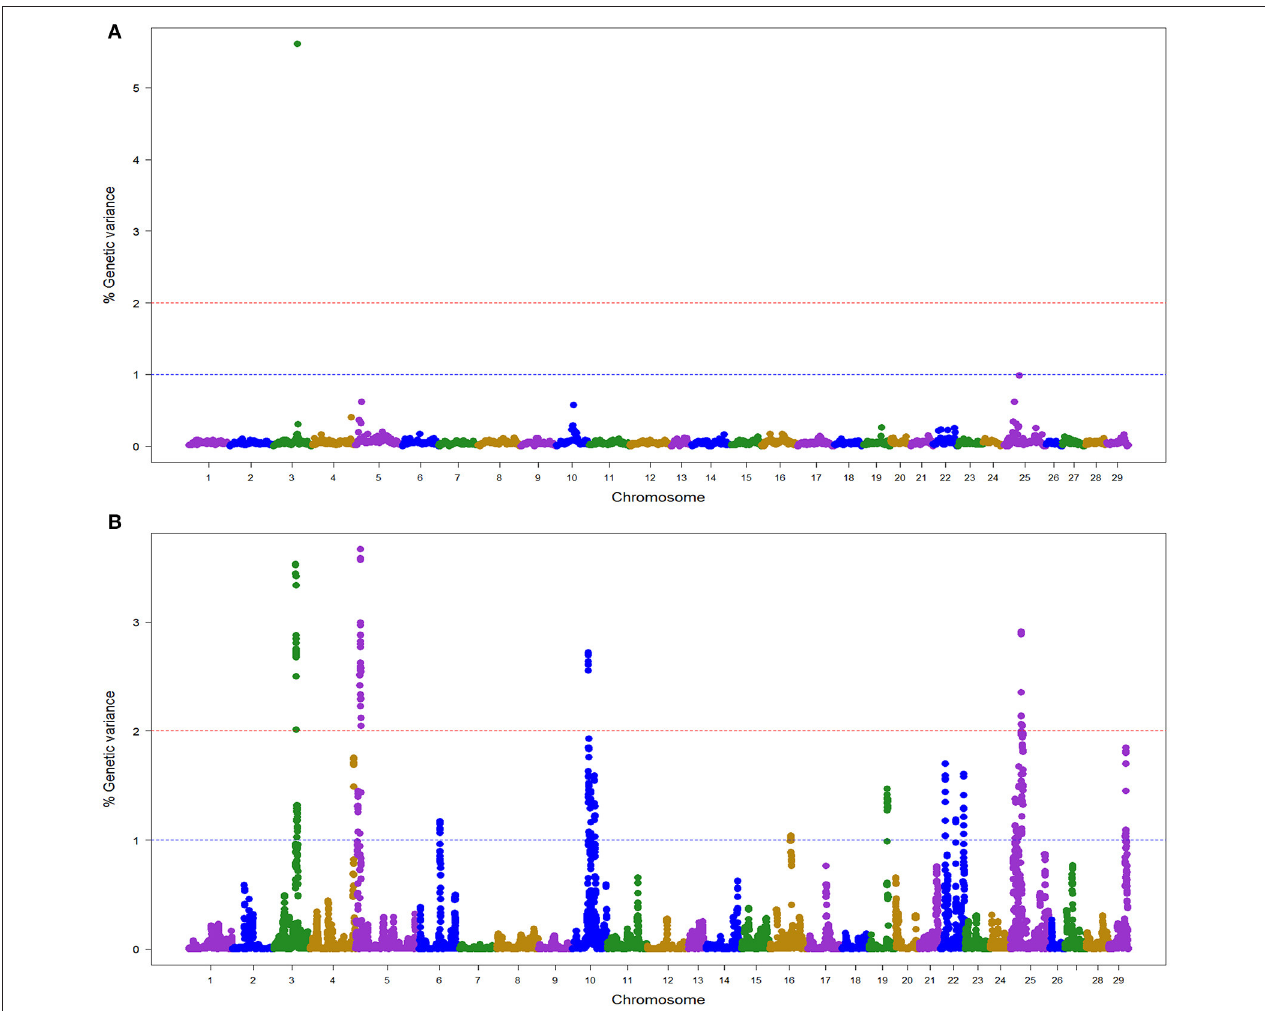
FIGURE 2 | Manhattan plot showing the association between SNP genomic windows and BCWD resistance in NCCCWA sample genotyped with 57K Chip-SNP: (A) GWAS for STATUS performed with BayesB using 1Mb exclusive windows. (B) GWAS for STATUS performed with wssGBLUP using 1Mb sliding windows.